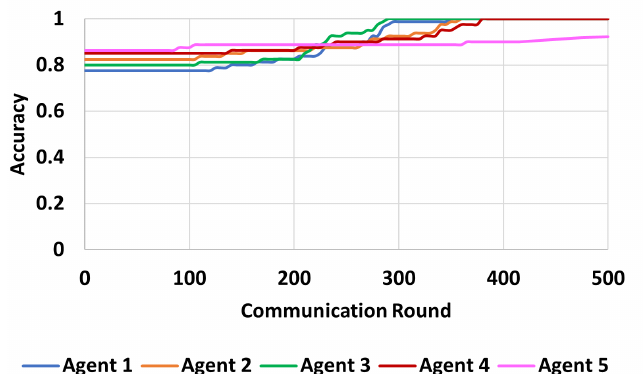
Figure 22. FedResilience’s impact on participating FL agents’ (five agents and three stragglers) model accuracy for the prediction of CIAs’ resource-sharing capability.